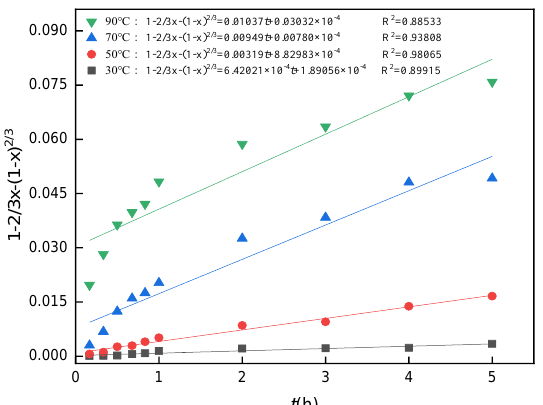
2/3 and time of aluminum ions.